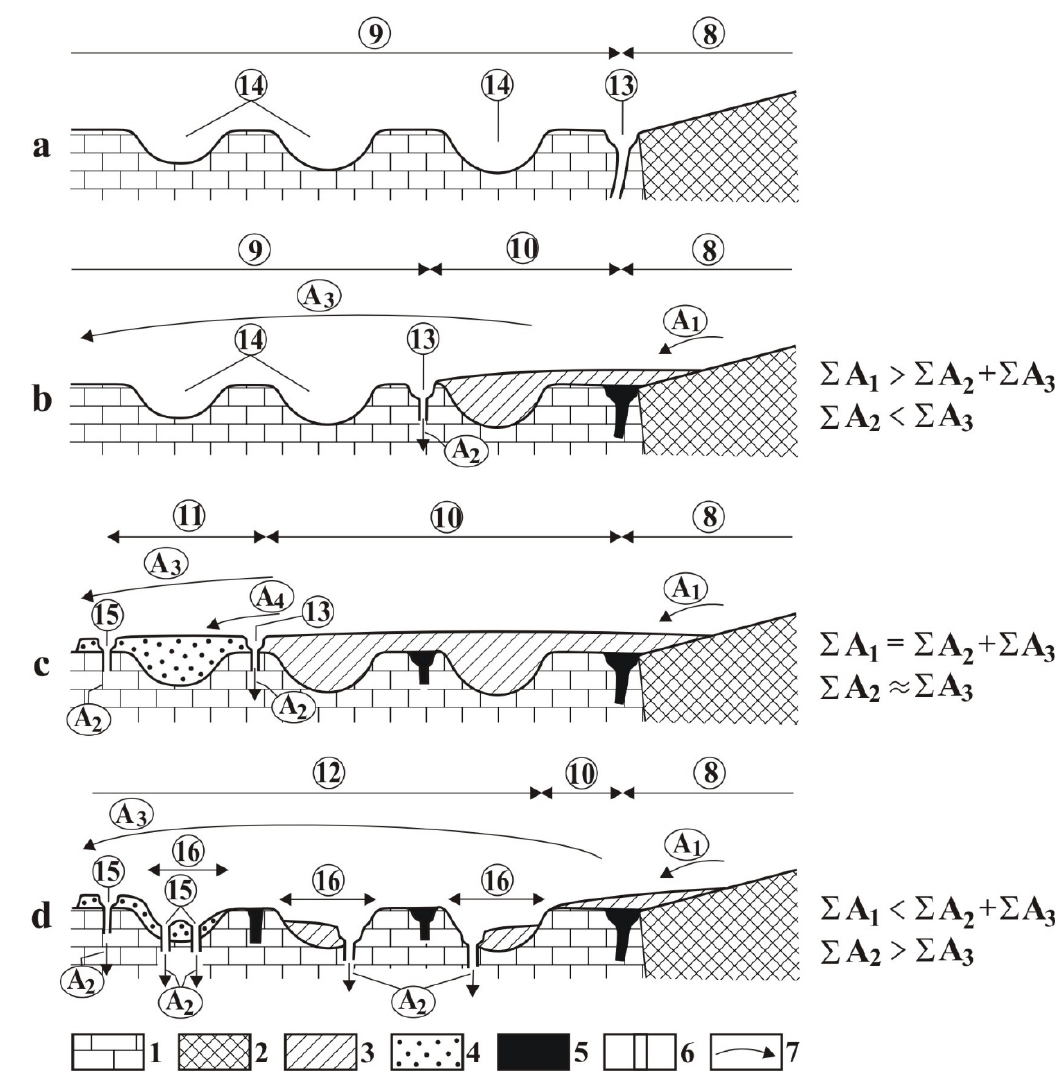
Figure 7. Reversible transformation on covered karst [35]. Legend: 1, limestone, 2, consolidated non-karstic rock (impermeable), 3, non-consolidated, impermeable, non-karstic rock, 4, non-impermeable, non-karstic rock, 5, ponor fill, 6, karst conduit, 7, sediment transport, 8, non-karstic terrain (buried karst), 9, bare karst, 10, cryptokarst zone, 11, concealed karst, 12, mixed composite karst, 13, ponor, 14, paleodoline, 15, subsidence doline, 16, true DSD. A 1 sediment transport upon the karst, A 2 sediment transport into the karst, A 3 outward sediment transport from the karst (fluvial), A 4 sediment redeposition within the covered karst, ( a ) bare karst, ( b ) beginning of covered karst evolution (the margin of the cover advances on the karst), ( c ) the bare karst transforms into covered karst (with cryptokarst and concealed karst zone), ( d ) the covered karst transforms into bare karst (the margin of the cover is retreating on the karst, the covered karst patches are shrinking).